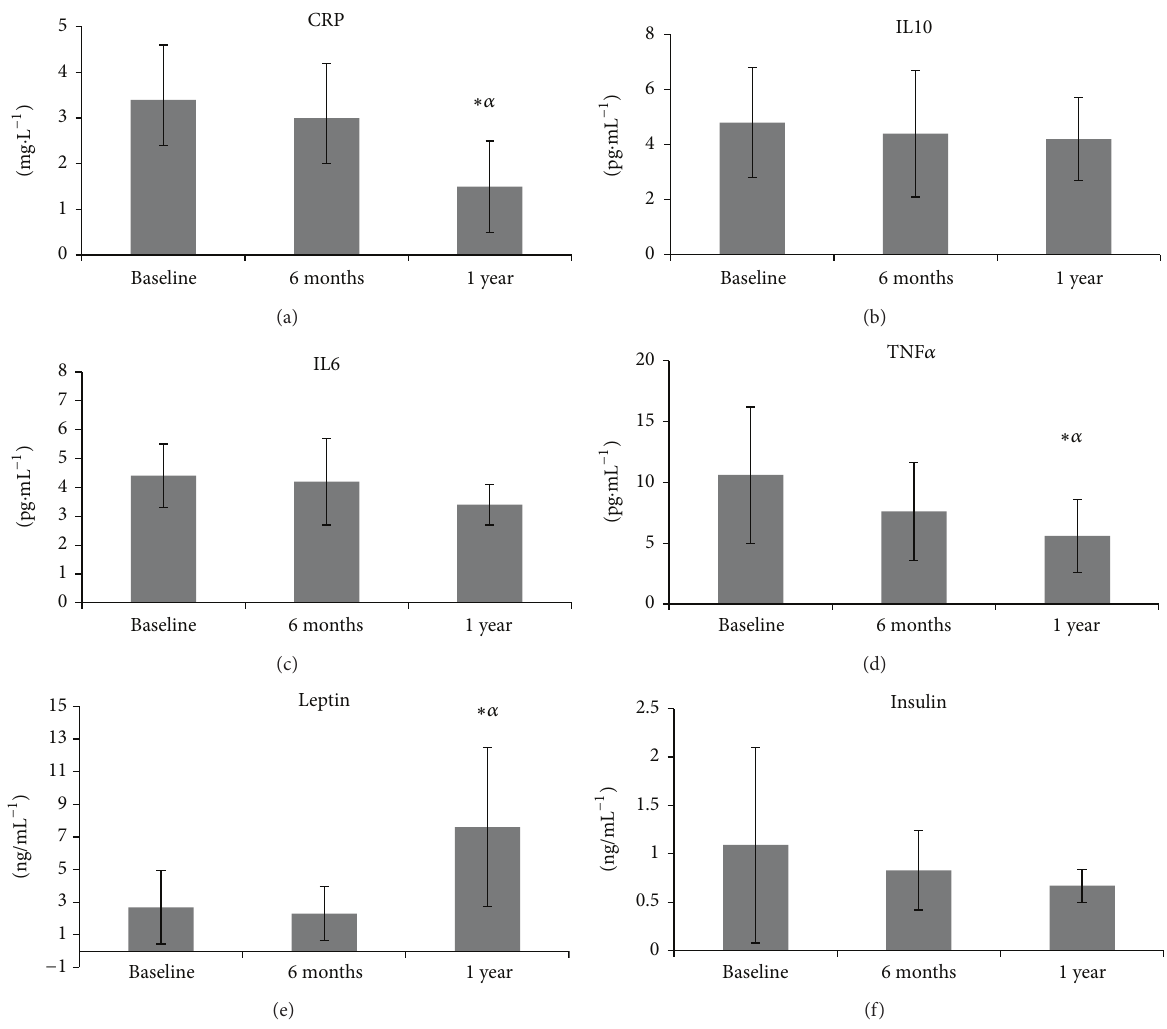
Figure 2: Levels of C-reactive protein (CRP), interleukin 10 (IL10), interleukin 6 (IL6), tumor necrosis factor alpha (TNF 𝛼 ), leptin, and insulin at baseline, after 6 months, and after 1 year of exercise intervention. ∗ Statistically significant difference from baseline. 𝛼 Statistically significant difference from 6